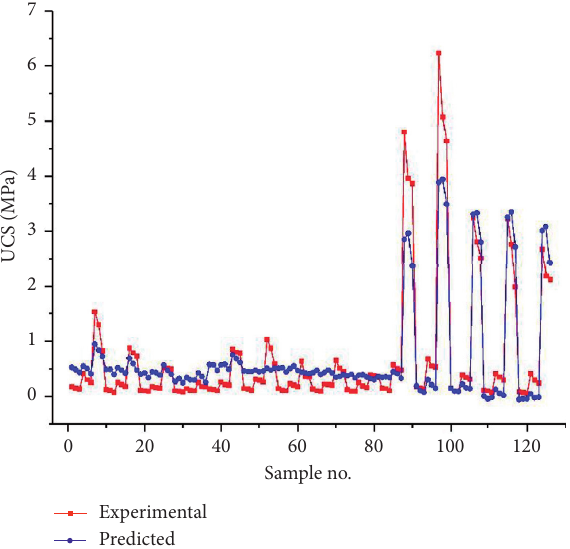
Figure 15: Performance visualization of the optimum DNN model on the whole